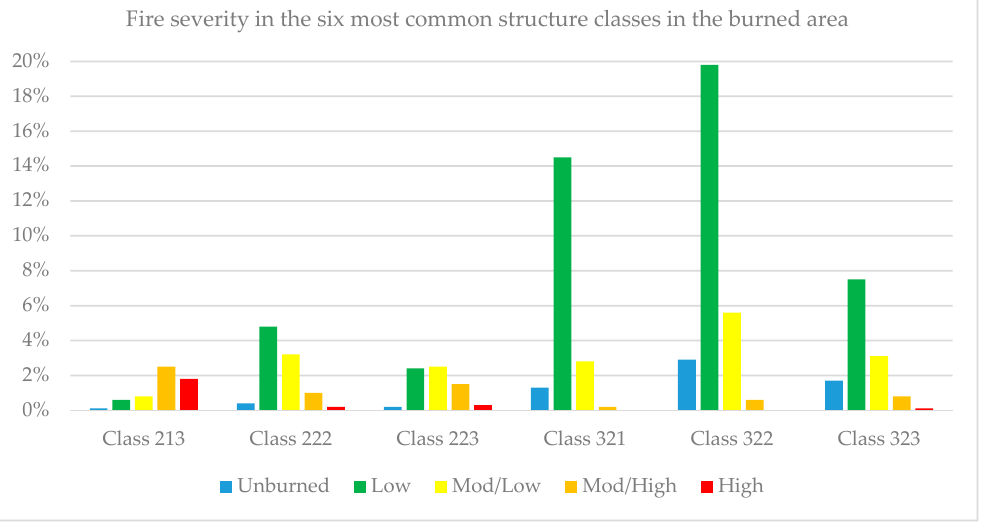
Figure 2. Fire severity in the six most common structure classes in the burned area. The Grand Canyon fire staff adjusted the original MTBS default severity class thresholds to match the CBI field data for each individual fire.